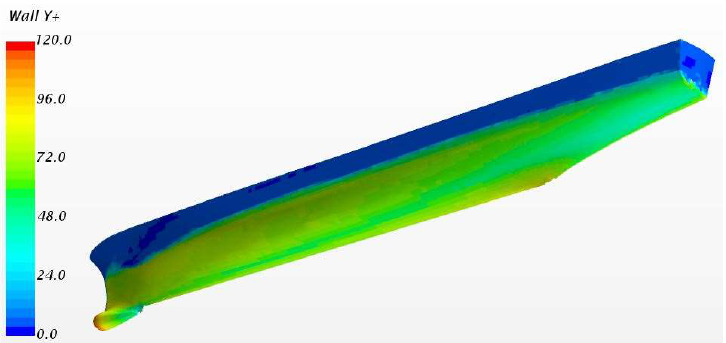
Figure 5. Y+ distribution on the hull for medium mesh. Table 4. Total resistance, sinkage and trim obtained by three sets of mesh for intact ship ( Fr = 0.28).